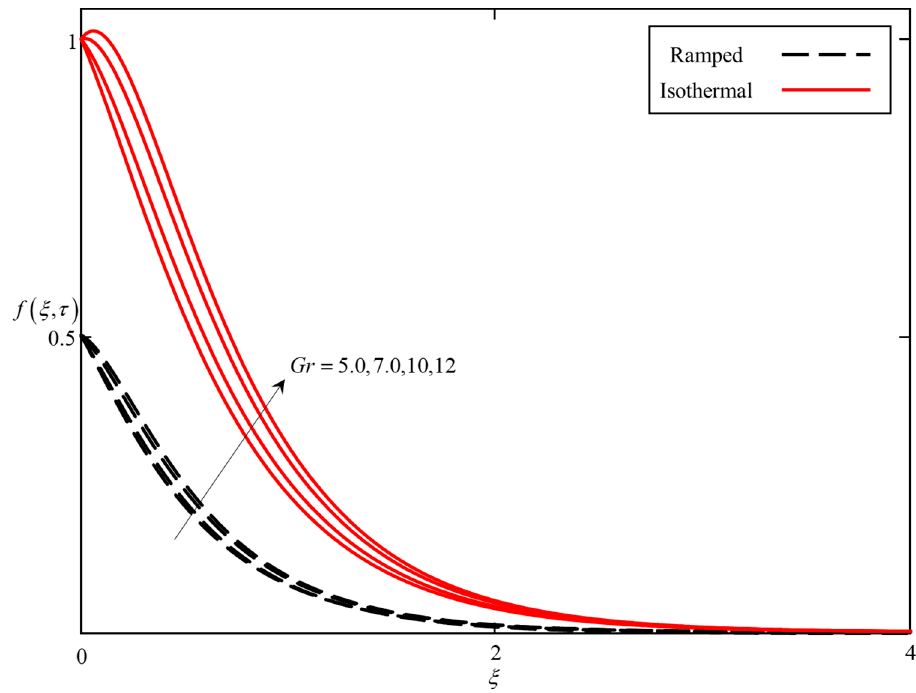
Figure 14. Consequence of Gr on the velocity field, when α = 0.5, β = 0.5, φ = 0.04, λ 1 = 0.5, λ 2 = 0.5, M = 0.5, K = 0.5, and Pr =